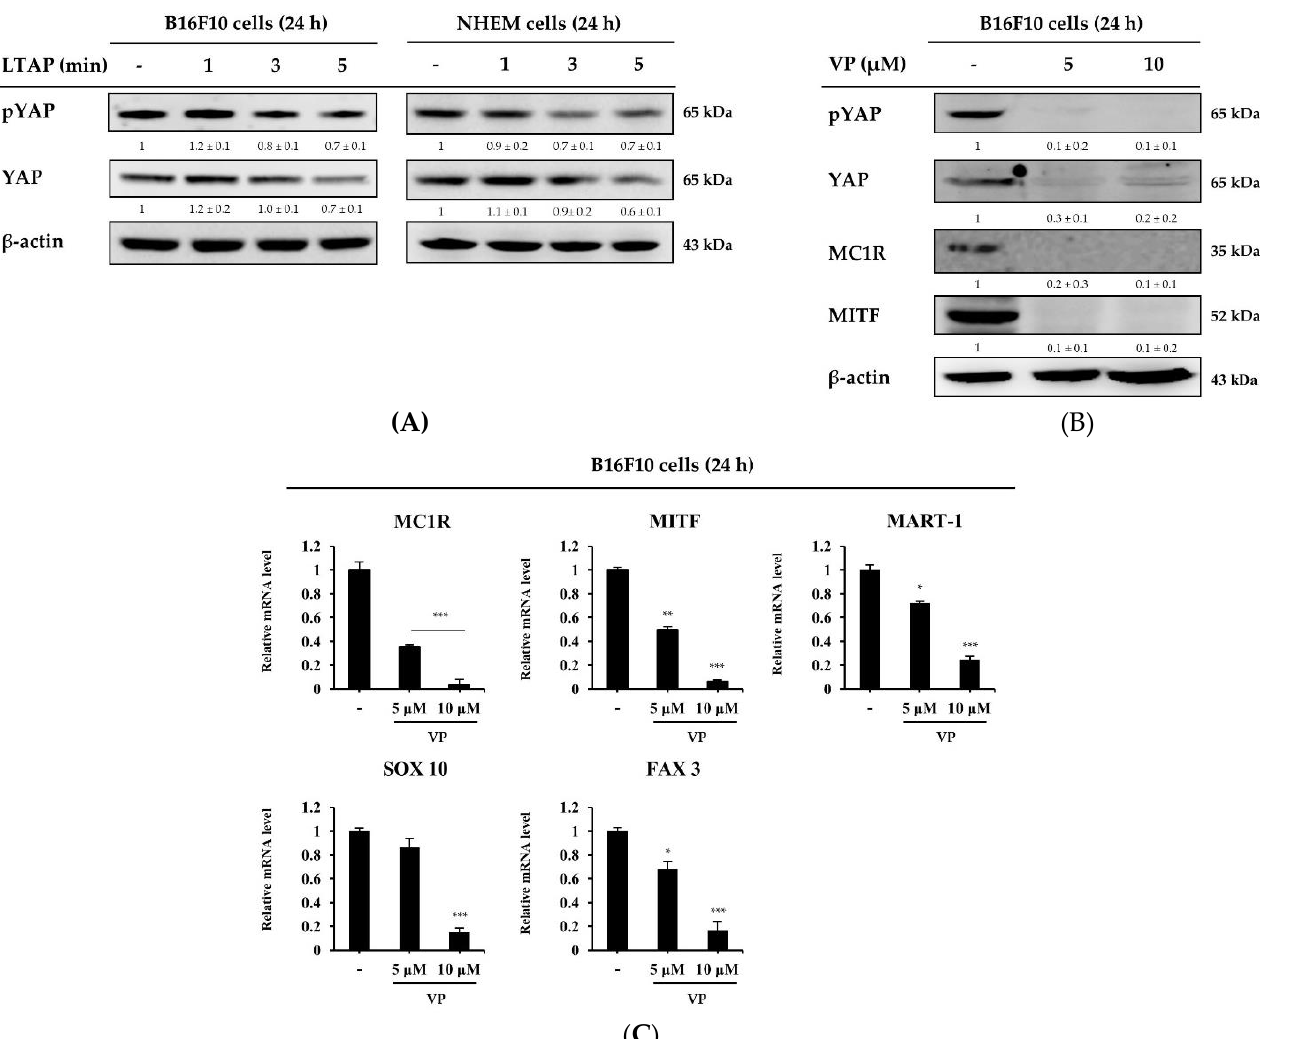
Figure 7. The YAP inhibitor VP decreases melanogenesis-related gene expression. ( A ) B16F10 cells and NHEMs were exposed to LTAP for 1, 3, or 5 min, and incubated further for 24 h. Cells were harvested and the levels of pYAP and YAP were evaluated by Western blotting. β -actin was used as a loading control. ( B,C ) B16F10 cells were treated with VP (5 or 10 μM), and further incubated for 24 h. Cells were harvested and the expression of pYAP, YAP, MC1R, and MITF was evaluated by Western blotting. Expression levels of MC1R, MITF, protein melan-A (MART-1), SRY (sex determining region Y)-box 10 (SOX10), and paired box gene 3 (PAX3 ) were measured by qRT-PCR. Data represent the mean ± SD. * p < 0.05, ** p < 0.01, *** p < 0.001. Numerical values on the blots represent DU. The control was normalized to 1 DU. All data represent three independent